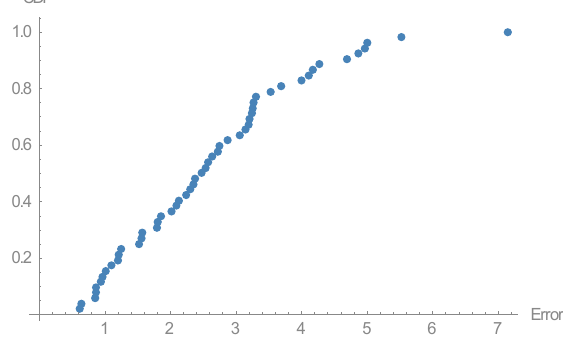
Figure 8. Cumulative Distribution Function (CDF) of the error of the 52 reference points.